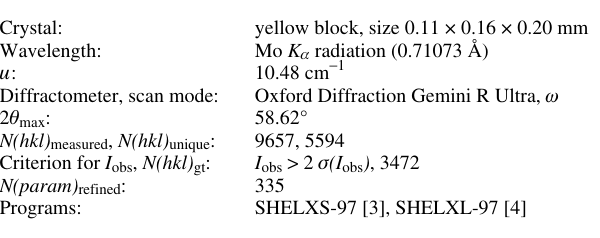
Table 1. Data collection and handling.